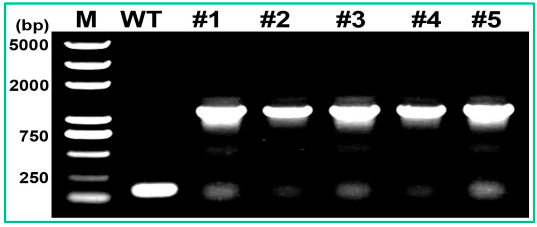
Figure 5. Different lines of PtMAPKK4 transgenic tobacco as detected by PCR, M: 5kb marker; #1–5: PtMAPKK4 of five transgenic lines.